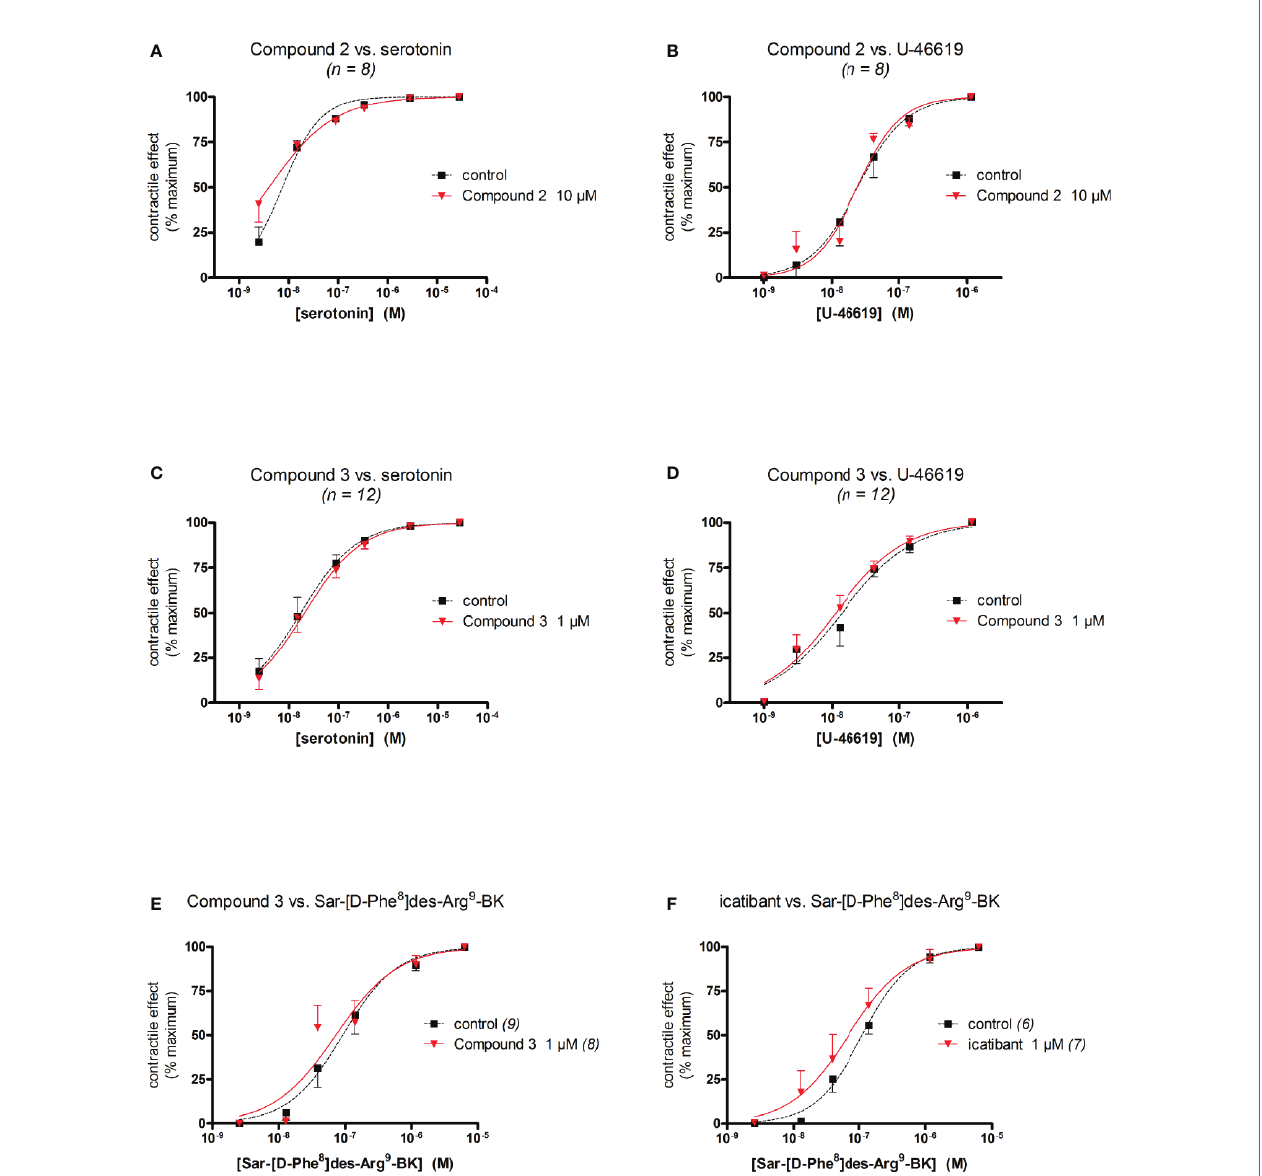
FIGURE 5 | Speci fi city of the antagonist effect of Compound 2 (A, B) , Compound 3 (C – E) or icatibant (F) in the human umbilical vein preparation (concentrations as indicated, replicate number indicated by n ). (A, C) Lack of antagonist effect on serotonin-induced contraction. (B, D) Lack of antagonist effect on U-46619-induced contraction. (E, F) Lack of Compound 3 and icatibant on the B 1 receptor agonist Sar-[D-Phe 8 ]des-Arg 9 -BK-induced contraction. Values are the means ± S.E.M. of the number of determinations indicated by n . For the sake of clarity, several error bars below or above the average values have been omitted. Agonist EC 50 values and overlapping con fi dence limits are reported in Table 5